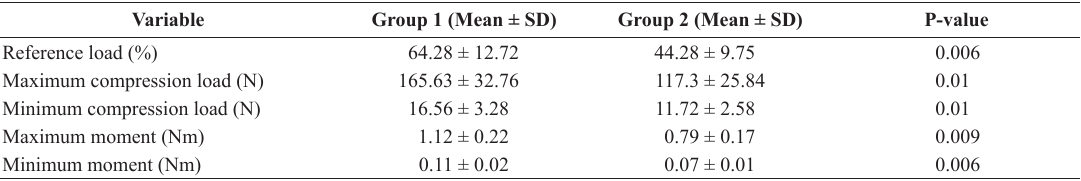
Table 4. Mean values and standard deviation (SD) for each variable evaluated in Groups 1 and 2 under fatigue axial compression testing. Variable